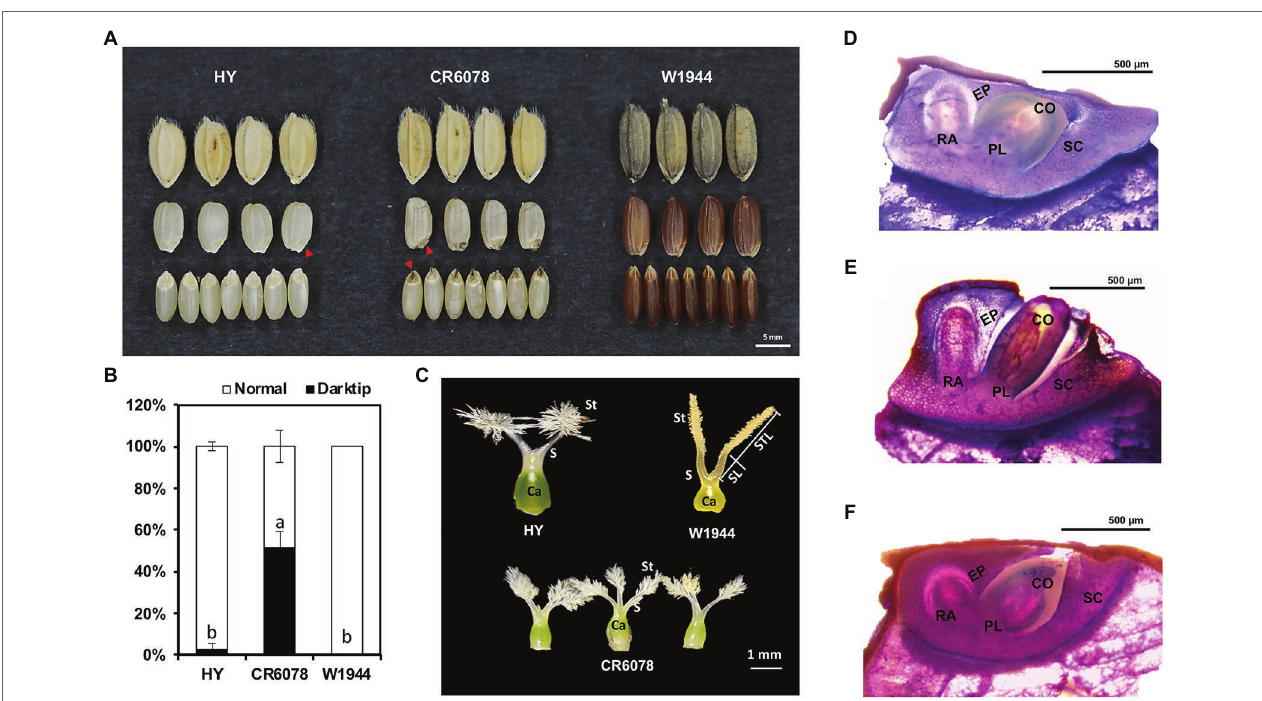
FIGURE 1 | Phenotypic differences among HY, W1944, and CR6078. (A) Seed morphology. Red arrowhead indicates the position of dark tip embryo (DTE) in CR6078. (B) Comparison of the dark tip embryo rate (%). (C) Characterization of the pistil phenotype in HY, W1944, and CR6078. The normal pistil with one carpel (Ca) and two stigmas (St) in HY and W1944. The aberrant pistils of CR6078. One carpel with three or four stigmas. (D–F) Section analysis. The seed longitudinal section was stained with 0.05% toluidine blue to compare the embryo shape of HY (D) , CR6078 (E) , and W1944 (F) . Ca, carpel; St, stigma; S, style; CO,